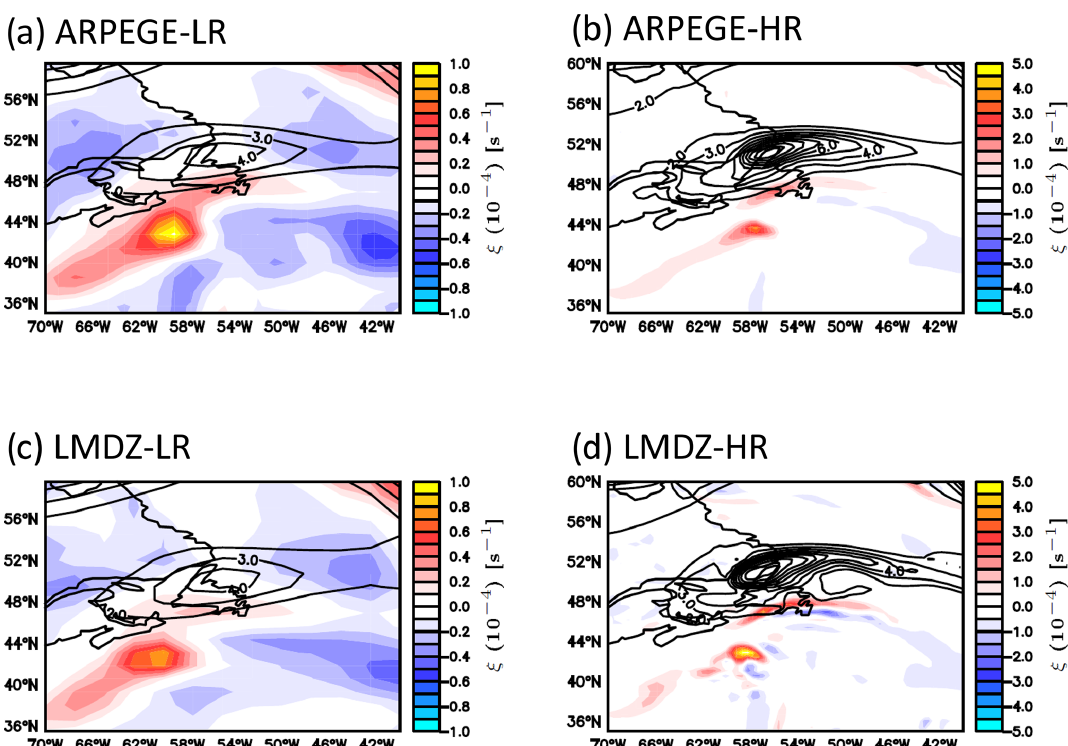
Figure 3. Hindcasts for the cyclogenesis of the Stalactite cyclone at 18:00UTC 29 September ( T + 18h) for hindcasts initiated at 00:00UTC 29 September. The 250hPa PV above 2PVU (contoured every 1 PVU) and the 850hPa relative vorticity (shaded) for (a) ARPEGE-LR,